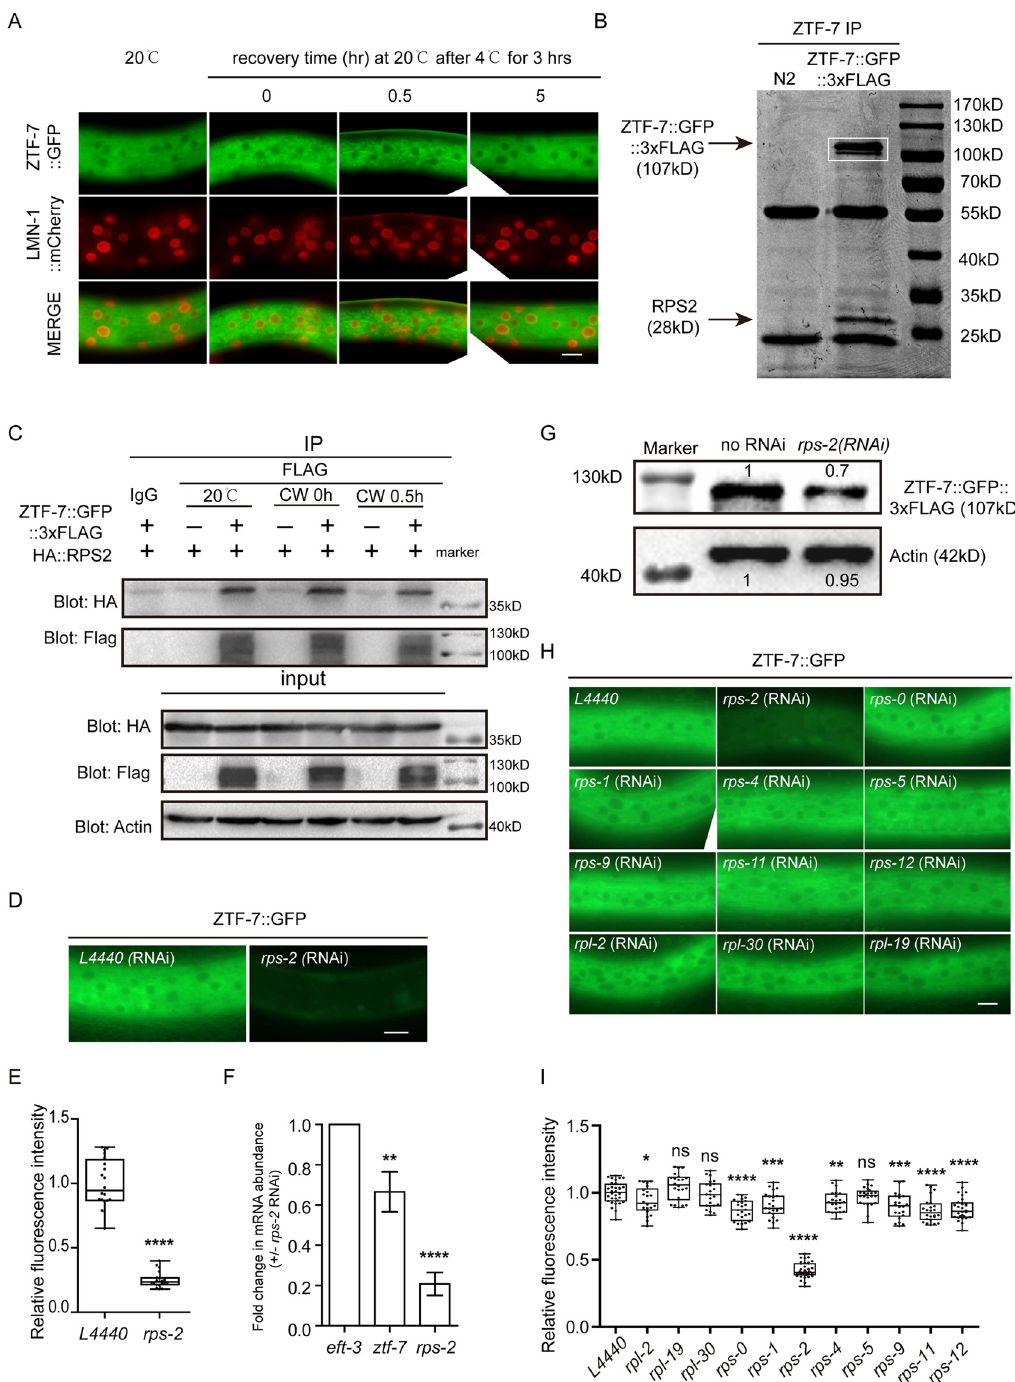
Fig 6. ZTF-7 interacts with RPS-2. (A) Images of somatic cells of L4 animals expressing ZTF-7::GFP after 4˚C for 3 hours. Scale bars, 10 μ m. (B) ZTF-7::GFP::3xFLAG was immunoprecipitated with an anti-FLAG antibody, resolved by SDS–PAGE and stained with Coomassie blue dye. ZTF-7::GFP::3xFLAG and RPS-2 bands are indicated by arrows. In the white box, both bands are ZTF-7::GFP::3xFLAG, as identified by mass spectrometry separately. (C) Co-IP assay in L3/L4 stage animals expressing ZTF- 7::GFP::3xFLAG and HA::RPS-2 using anti-FLAG antibody. RPS-2 was detected by an anti-HA antibody. (D) Images of somatic cells of animals expressing ZTF-7::GFP after treatment with RNAi targeting rps-2 . Scale bars, 10 μ m. Animals were cultured at 20˚C. (E) Box plots showed relative fluorescence intensities of ZTF-7::GFP::3xFLAG after knocking down rps-2 by RNAi. n = 20. Two-tailed Student’s t test. ���� P < 0.0001. (F) Quantification of ztf-7 mRNA levels after RNAi rps-2 . mean ± s.d. n = 3.